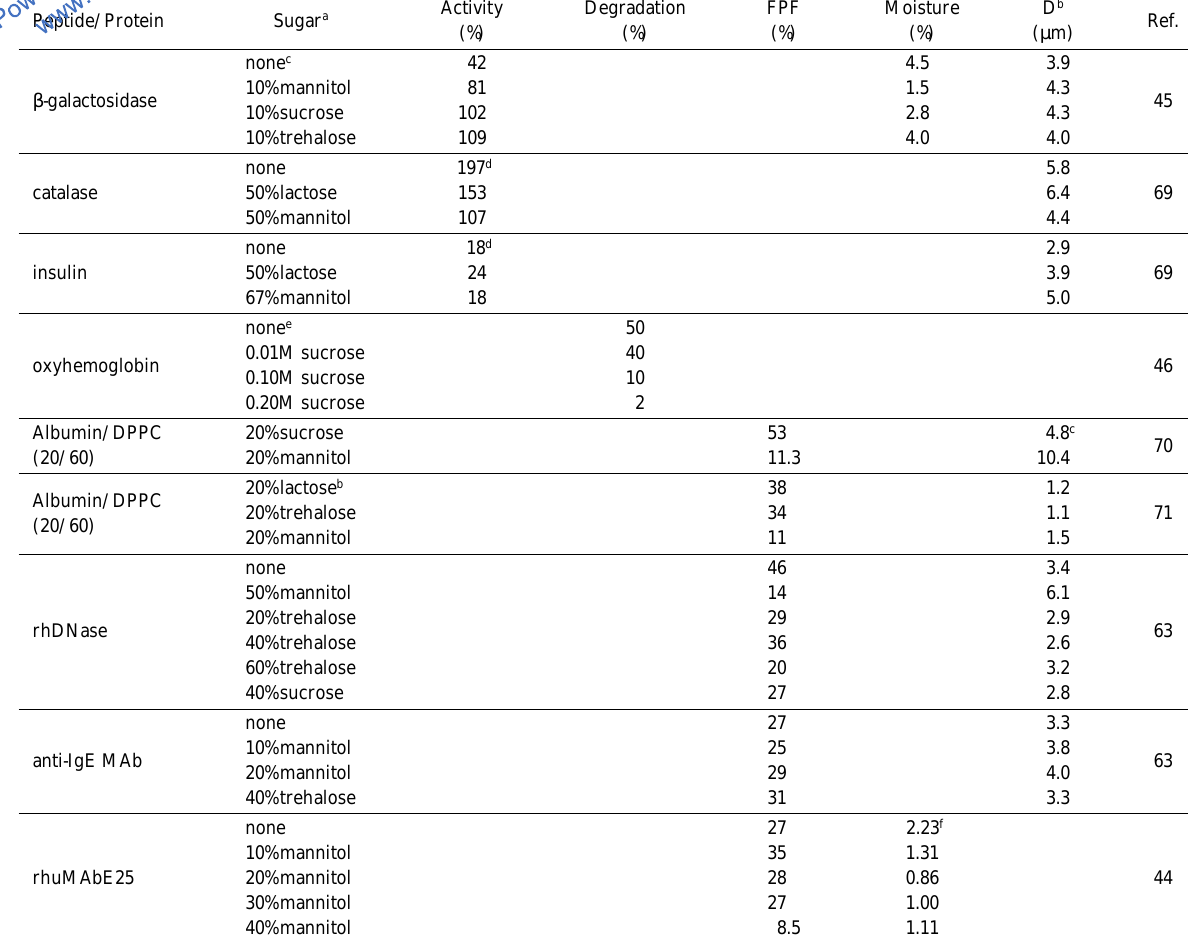
a Percentage stands for the sugar content in dry powder except for β -galactosidase and oxyhemoglobin. b Geometric or aerodynamic